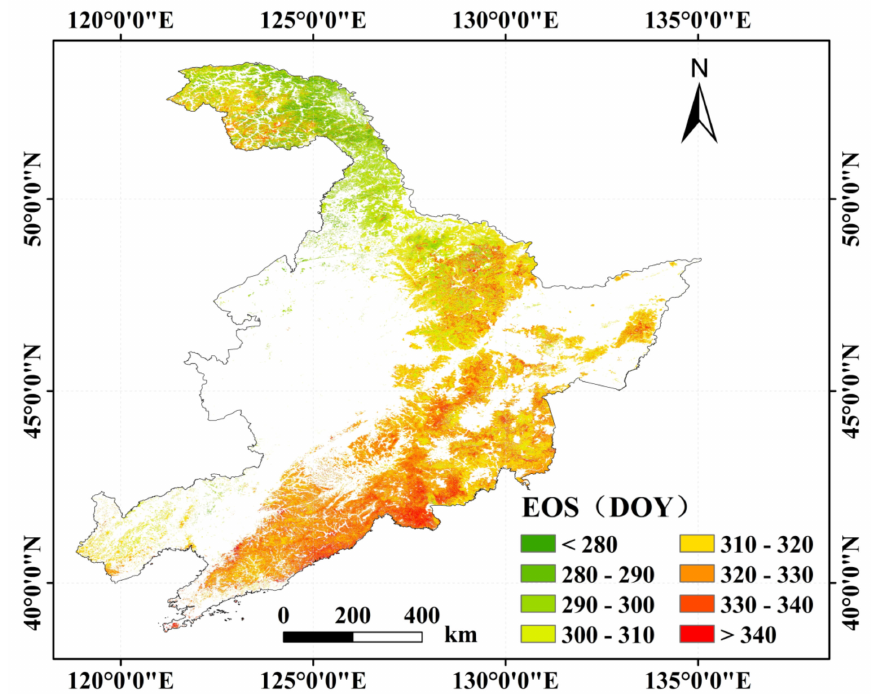
Figure 7. The spatial distribution of the average EOS (end of the growing season) from 2011 to 2020 in the northeast China.